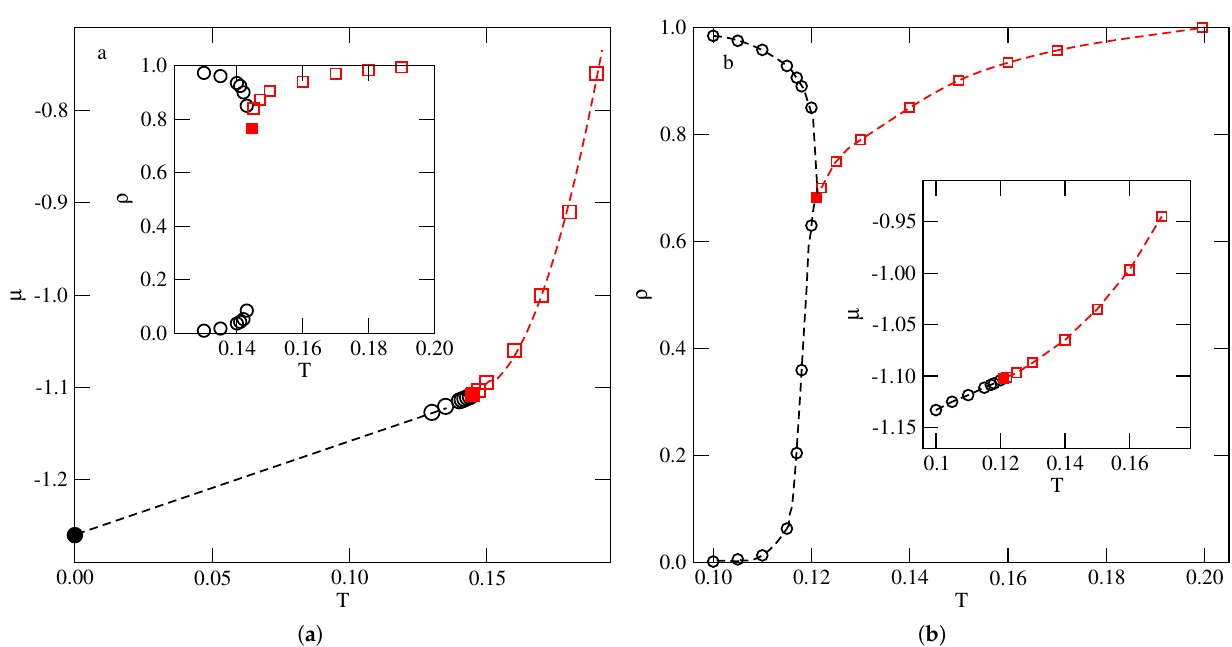
Figure 8. The phase diagrams evaluated for the systems with u ∗ = − 0.05 ( a ), and − 0.03 ( b ). Open circles and squares show the phase boundaries for the first − order and second − order transitions, respectively. The filled squares mark the locations of the tricritical points. In the main panel, the location of the gas–zigzag transition in the ground state is marked by the filled circle.